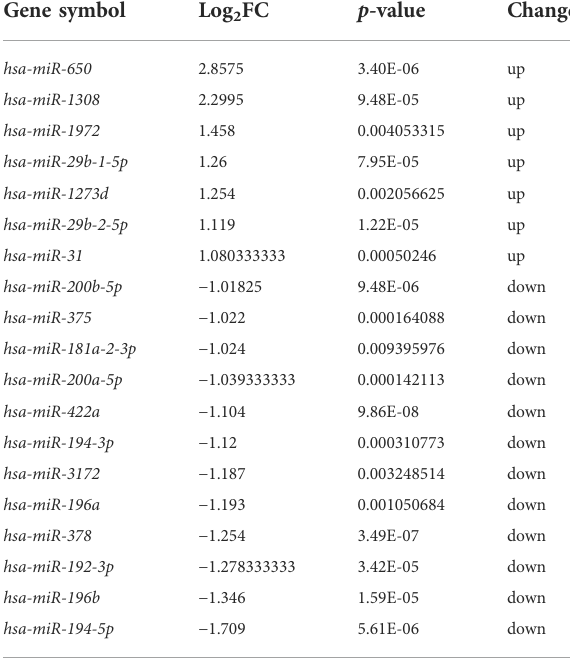
TABLE 2 Difference analysis results of miRNAs in dataset